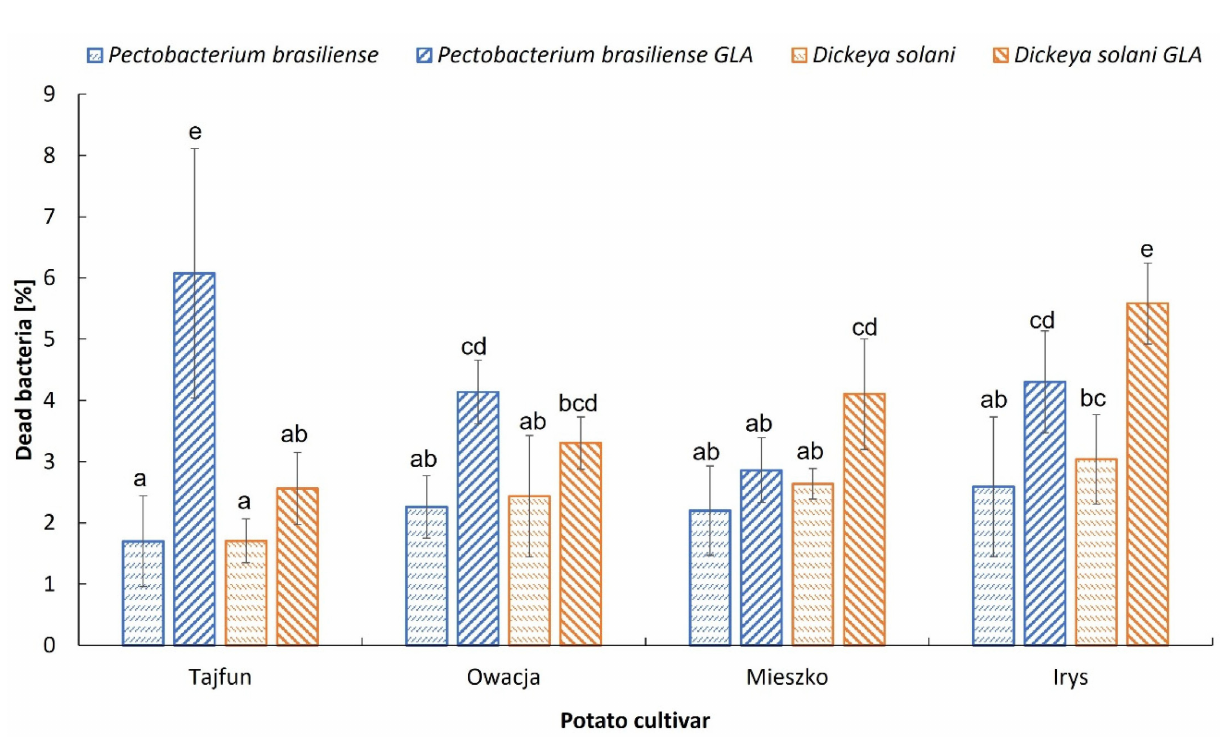
Figure 2. Percentage of dead cells of P. brasiliense and D. solani after 48 h growth in Luria Berthani medium (control) and Luria Berthani medium with glycoalkaloids isolated from leaves of four potato cultivars. Means marked with the same letter within strain do not differ significantly according to Duncan’s test at p = 0.05.